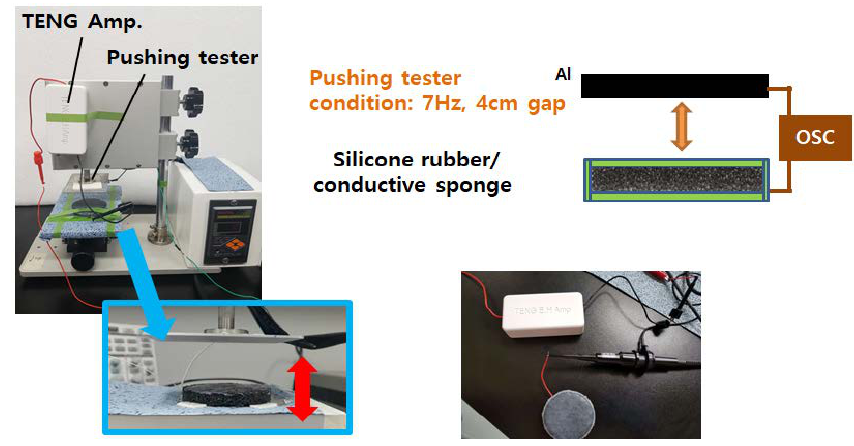
Figure 4. Measurement of output of the TENG specimen using the pushing tester.